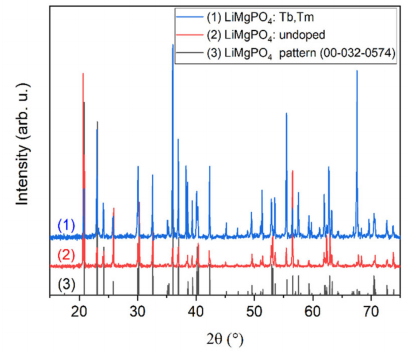
Figure 2. The XRD di ff raction patterns of the undoped and Tb 3 + plus Tm 3 + double-doped LMP crystals investigated in this work. The patterns were shifted vertically for more